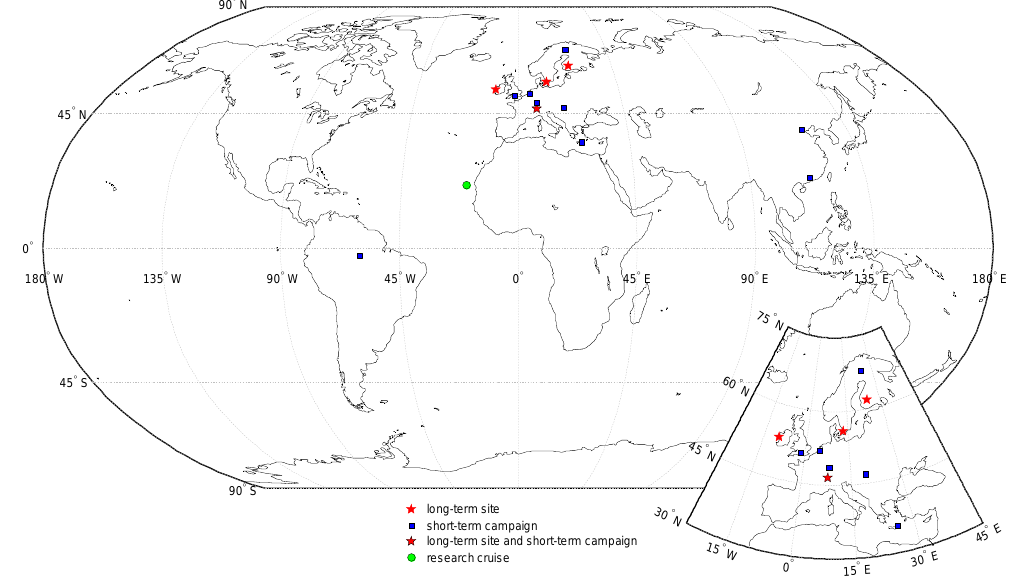
Figure 1. A world map showing the locations of CCNC measurements performed during EUCAARI and presented in this study. Table 1. Names, locations and descriptions of all measurement sites presented in the analysis. Name of station or